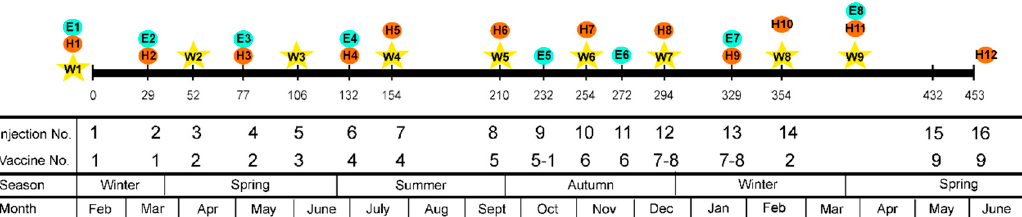
Figure 1. Global inoculation schedule. Each injection date is indicated by a vertical line and a number (mean value of dpi of the four flocks). W: Weight measurement. E: Clinical examination. H: Hematological analysis. Information on the injection and vaccines number, season, and month is also provided. Inoculation schedule for each individual flock is provided in Figure A1 (Appendix B). Information about the vaccines used is presented in Table A2 (Appendix